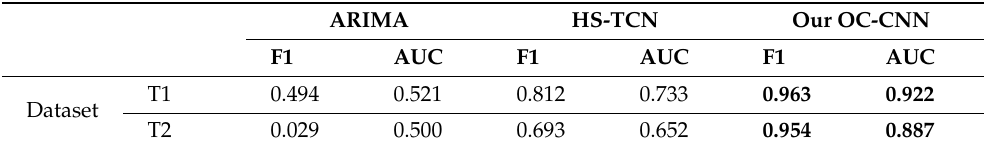
Table 4. Performance comparison of different methods using F1-score (noted as F1) and AUC score averaged of five runs, the bold scores indicate the highest mean scores obtained in test phase, T1 (Testdata1) and T2 (Testdata2). ARIMA HS-TCN Our OC-CNN F1 AUC F1 AUC F1 AUC T1 0.494 0.521 0.812 0.733 0.963 0.922 Dataset T2 0.029 0.500 0.693 0.652 0.954